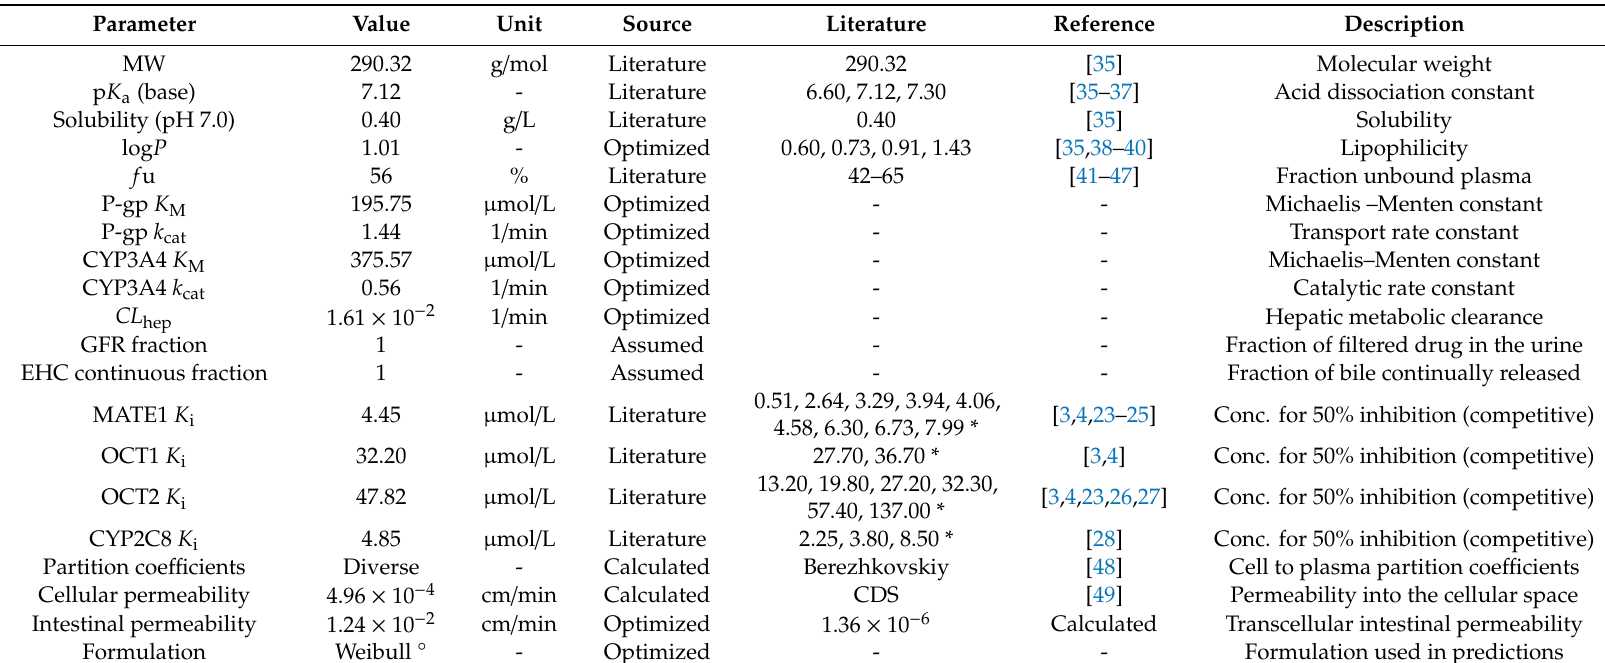
Table 1. Trimethoprim drug-dependent